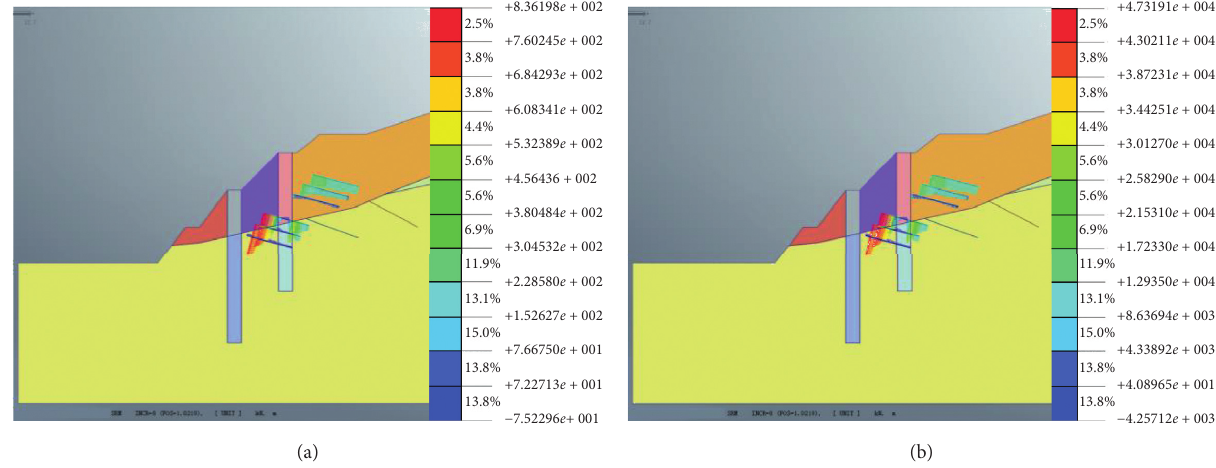
Figure 10: Cloud diagrams of the prestressed anchor cable without considering steady-state seepage. (a) Axial force cloud diagram. (b) Axial stress cloud